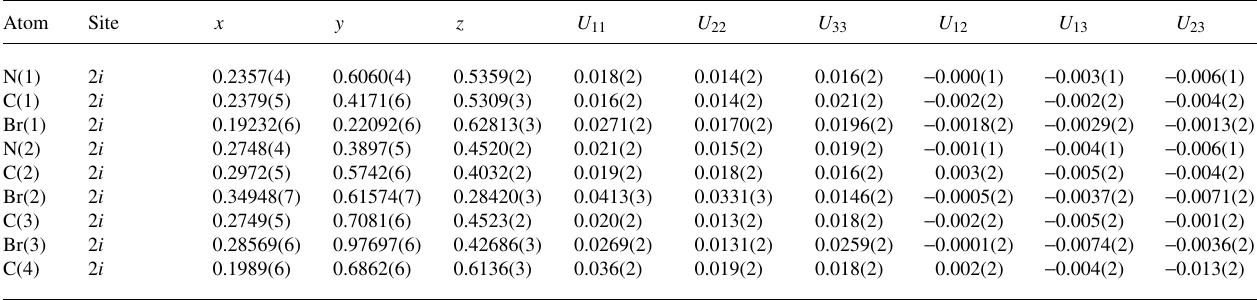
Table 3. Atomic coordinates and displacement parameters (in Å 2 )